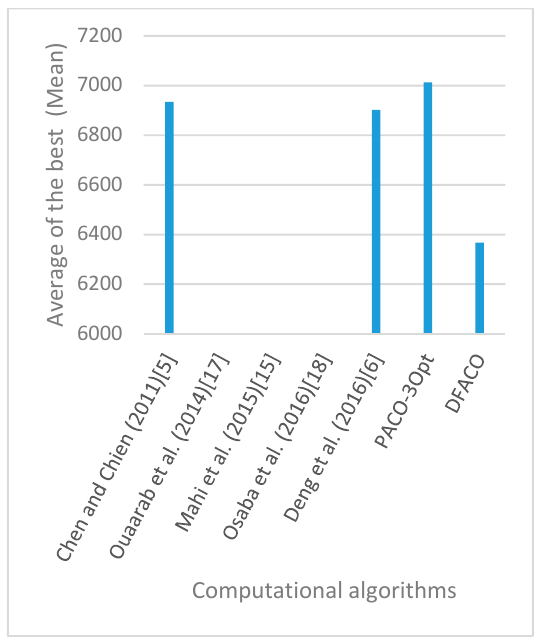
Figure 27. Average of best solutions obtained for instance rat575 by all algorithms.